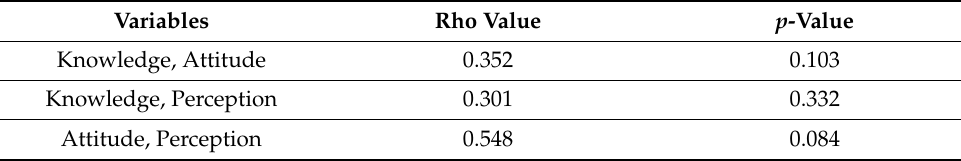
Table 7. Correlation between various domains of KAP for participants’ response.